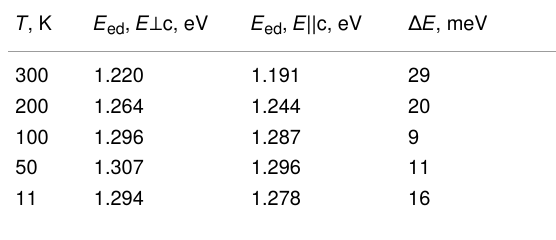
Table 1: The differences ( Δ E ) in the absorption edge positions ( E ed ) for Е || с ( E ed ( E ⟂ c)) and Е ⟂с ( E ed ( E ||c)) polarization conditions at differ- ent